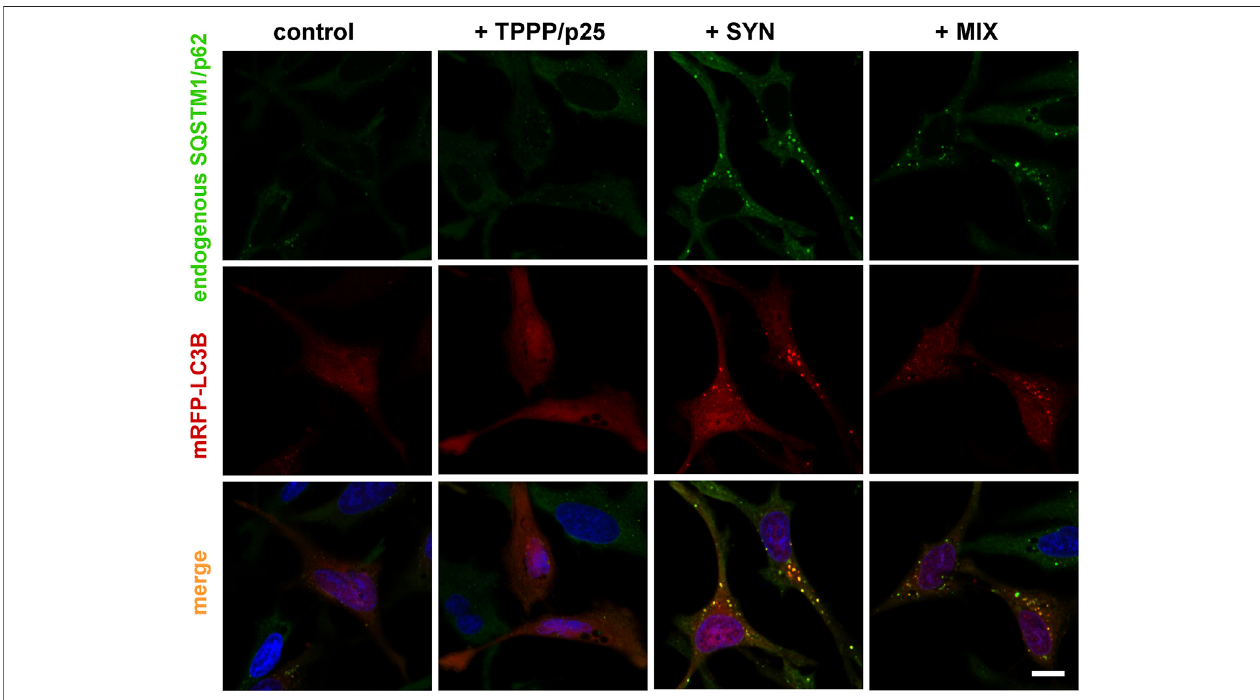
FIGURE2| RepresentativeimagesillustratetheeffectsofTPPP/p25and/orSYNontheco-localizationofLC3B(red)andendogenousSQSTM1/p62(green).SYN, TPPP/p25ortheirmixture(MIX,80 nMTPPP/p25and800 nMSYN)wereaddedtothemediumofHeLacellstransfectedwithmRFP-LC3BasdescribedintheMaterials and Methods; and the co-localization of the autophagosome markers was visualized by immuno fl uorescence confocal microscopy; nuclei were counterstained with DAPI (blue). Scale bar: 5 μ